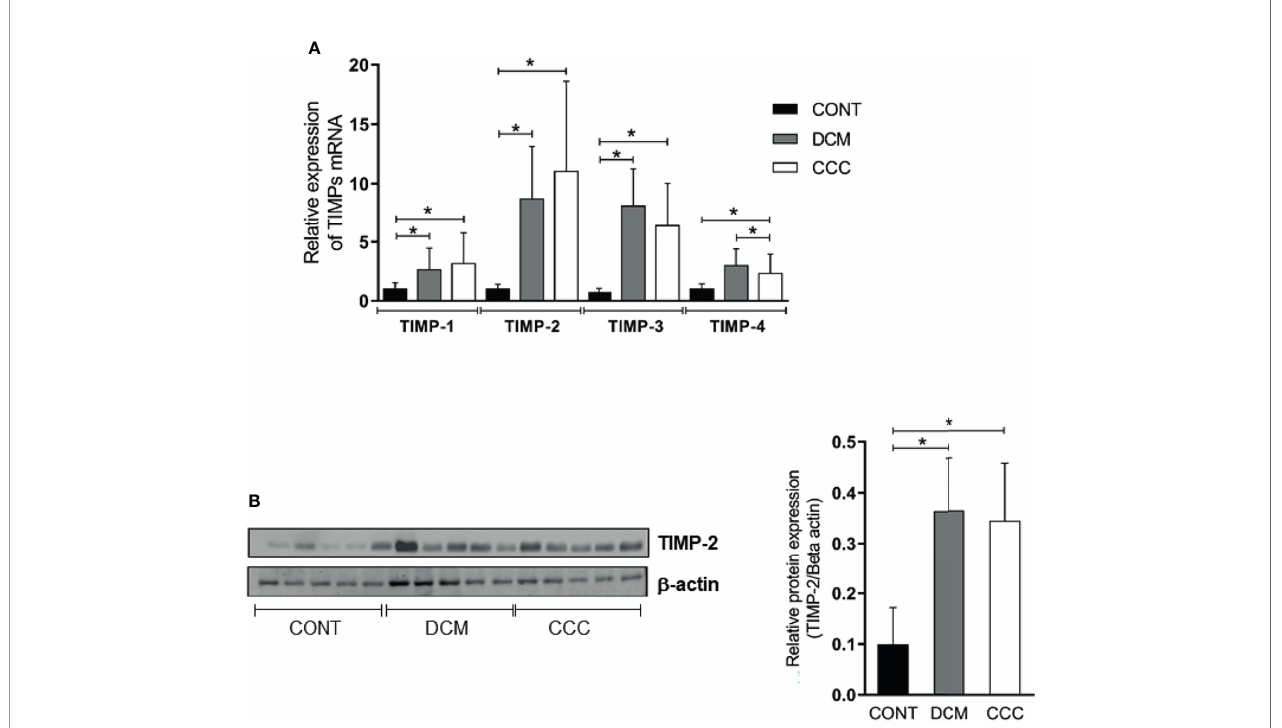
FIGURE 4 | Tissue inhibitors of MMPs (TIMPs) mRNA expression and protein expression in heart tissue from CCC and DCM samples. Real-time PCR analysis of mRNA expression in control (n = 6), DCM (n = 12) and CCC (n = 17) myocardium. The expression was calculated as the mean ± SD for each group as individual data points using the relative expression (fold change over control) by the 2 − DD Ct method, normalized with the endogenous gene RPL0, as described in the Materials and Methods section. (A) Relative expression of TIMP-1 mRNA; TIMP-2 mRNA ; TIMP-3 mRNA; TIMP-4 mRNA. (B) Western blotting image showing protein of the 21 kDa TIMP-2 bands in extracts from myocardium samples from the control, DCM and CCC (n = 5 in each group). The densitometric values of TIMP-2 protein for each sample were normalized by the values of 42 kD Beta actin band, as described in the Materials and Methods section. Groups were compared by a non- parametrical test (Mann – Whitney Rank Sum Test) with GraphPad Prism software (version 6.0; GraphPad). Results were expressed as mean ± SD. *P -values were considered signi fi cant if p-value (0.05) corrected for multiple comparisons by Bonferroni ’ s method (corrected p-value = 0.05/3 =